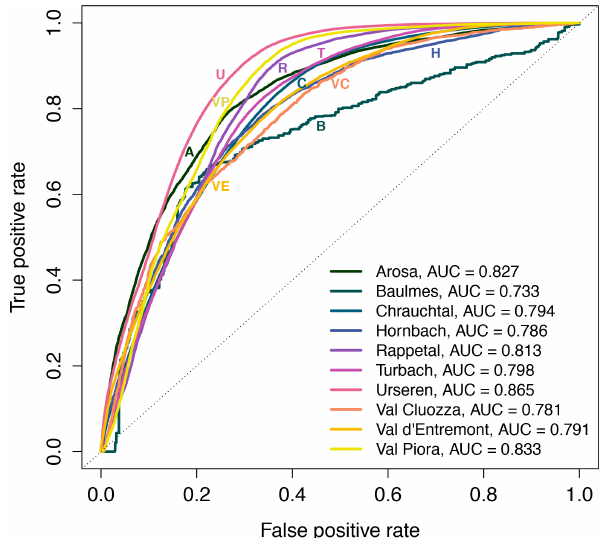
Figure 8. ROC performance measure of the models for all 10 sites. Plot displays ROC curves with corresponding AUC values.